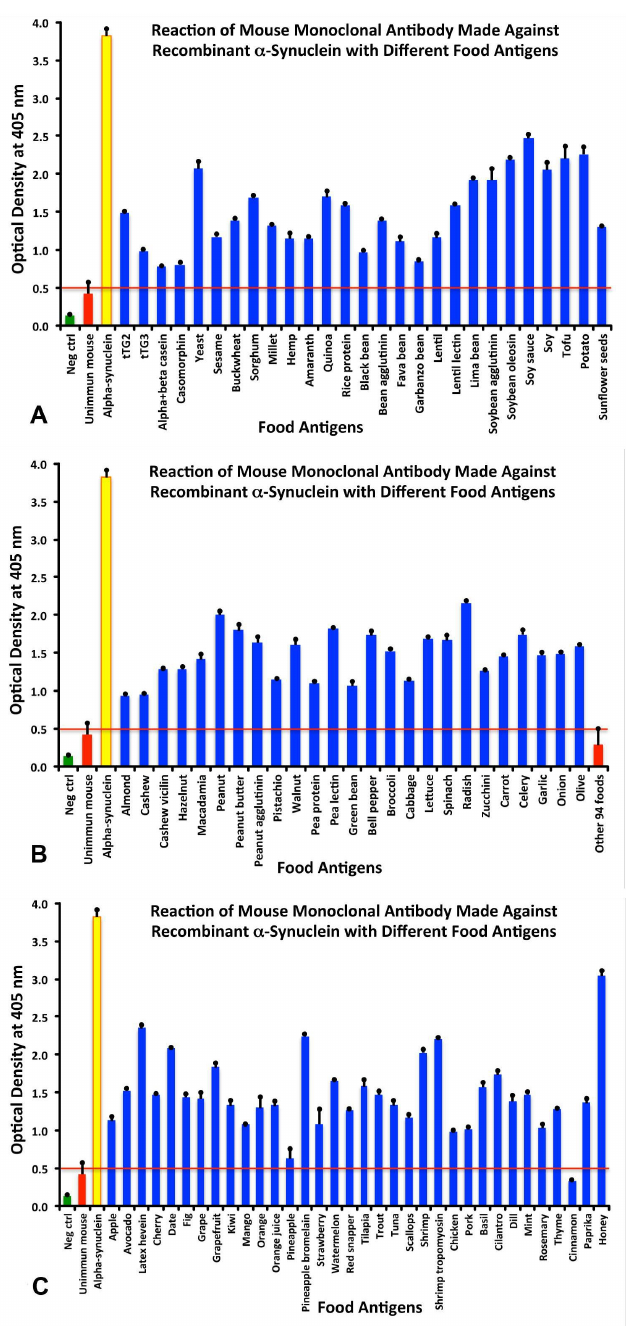
Figure 1. ( A–C ) Reaction of mouse monoclonal antibody made against recombinant aSN with different food antigens. tTG — tissue transglutaminase.